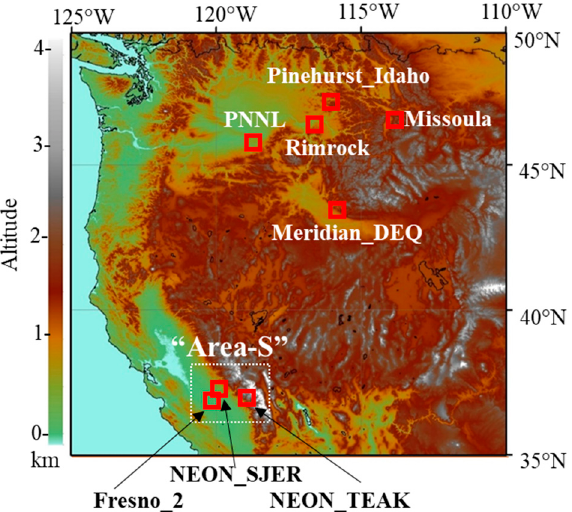
Figure 4. NASA/AERONET stations on the topographic map of the United States Pacific Northwest. Image is derived from the Advanced Spaceborne Thermal Emission and Reflection Radiometer (ASTER) global digital elevation model (V003). Each AERONET station is denoted by a red box. The area of study where data were collected is identified in a white dotted box (Area-S).